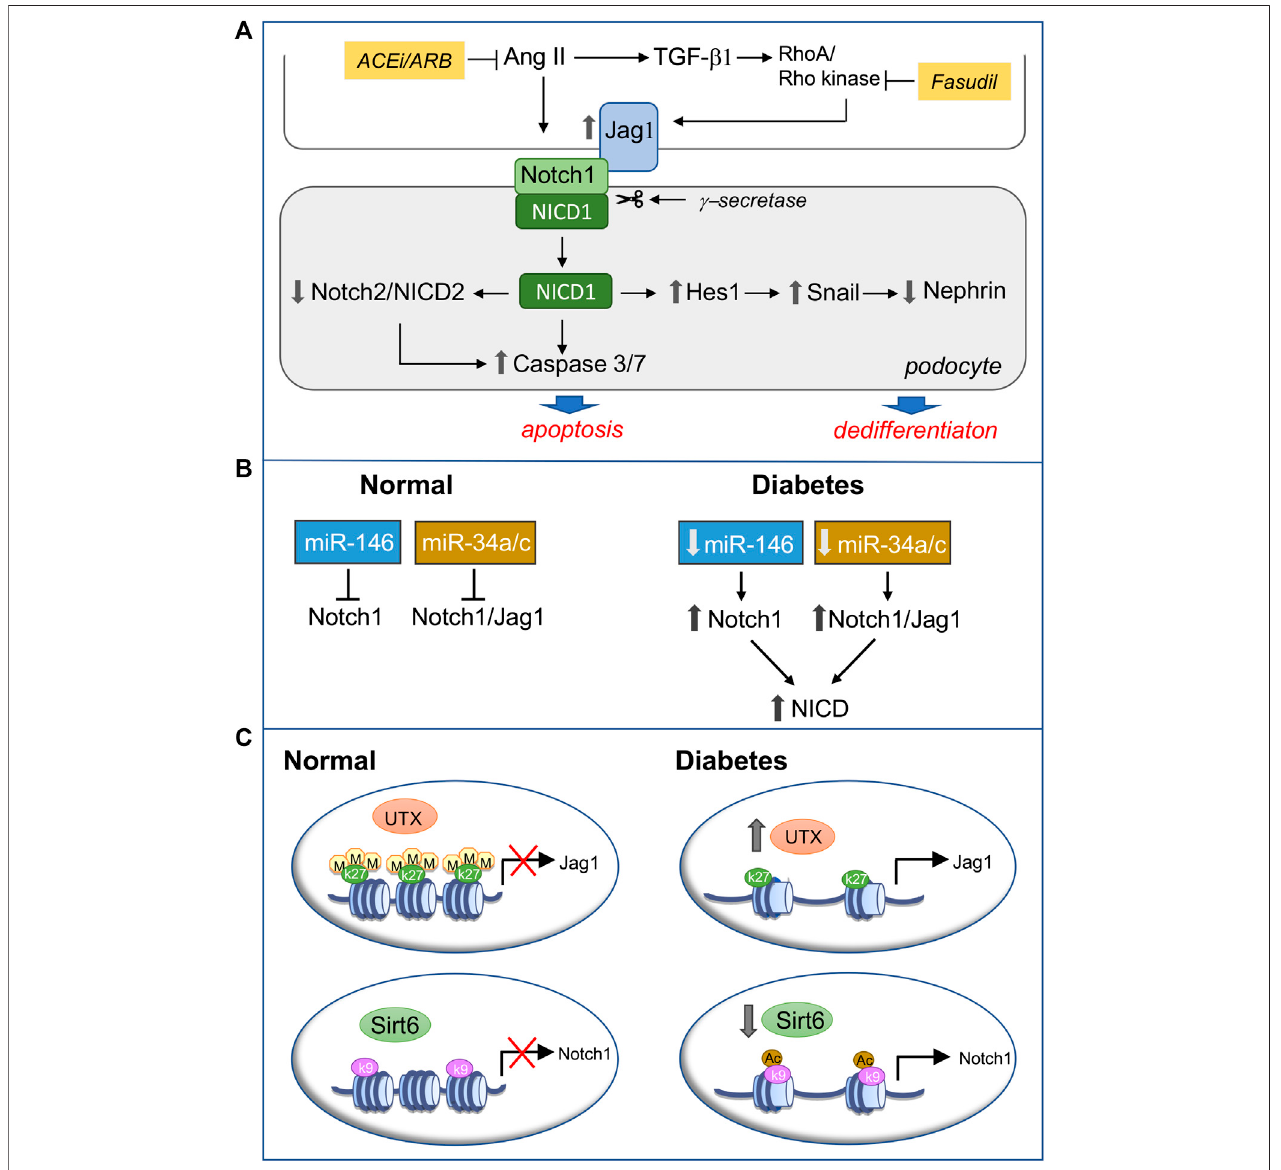
FIGURE3| ModulationofpodocyteNotch1signalingindiabeticnephropathy(DN). (A) PharmacologicalinhibitionofactiveNotch1inducers.AngIIandTGF- β drive podocyte injury in diabetes through the activation of Notch1 signaling. Following Jag1 engagement Notch1 is cleaved by c -secretase and the released Notch1 intracellular domain (NICD1), via Hes1, induces sustained Snail expression, which represses nephrin, leading to podocyte dedifferentiation. On the other hand, NICD1 downregulates Notch2 and NICD2 and activates proapoptotic pathways, promoting podocyte apoptosis. Targeting Ang II by RAS inhibition and TGF- β -induced upregulation of Jag1 with the Rho kinase inhibitor fasudil prevents Notch1-mediated podocyte phenotypic changes and loss, ameliorating DN (B , C) . Epigenetic regulation of Notch1 signaling through miRNAs (B) or posttranslational histone modi fi cation (C). (B) In normal, mature, differentiated podocytes miR-146a and miRNA 34a/c prevent Notch1 signaling activation by targeting the3 ′ UTR of Notch1 or both Notch1 and Jag1, thus decreasing their mRNA and proteinexpression. Conversely, diabetes and hyperglycemia-induced downregulation of miR-146a and miRNA 34a/c result in Notch1 signaling activation in podocytes (C) In healthy podocytes the trimethylationoflysineresidue27onhistoneprotein H3(H3K27me3)intheJag1promoterandtheSirt6-mediated deacetylation oflysineresidue nineonhistoneprotein H3 (H3K9) in the Notch1 promoter keep the Notch1 signaling pathway silent. In diabetes, reduced H3K27me3 – dependent on the overexpression of the demethylase UTX – and increased H3K9ac due to Sirt6 downregulation relieve the repression of Jag1 and Notch1, respectively, switching on Notch1 signaling in podocytes. ACEi, angiotensinconverting enzymeinhibitor;ARB,angiotensin receptor blocker;UTX,JumonjiCdomain-containingfamily:ubiquitously transcribedtetratricopeptide repeat on chromosome